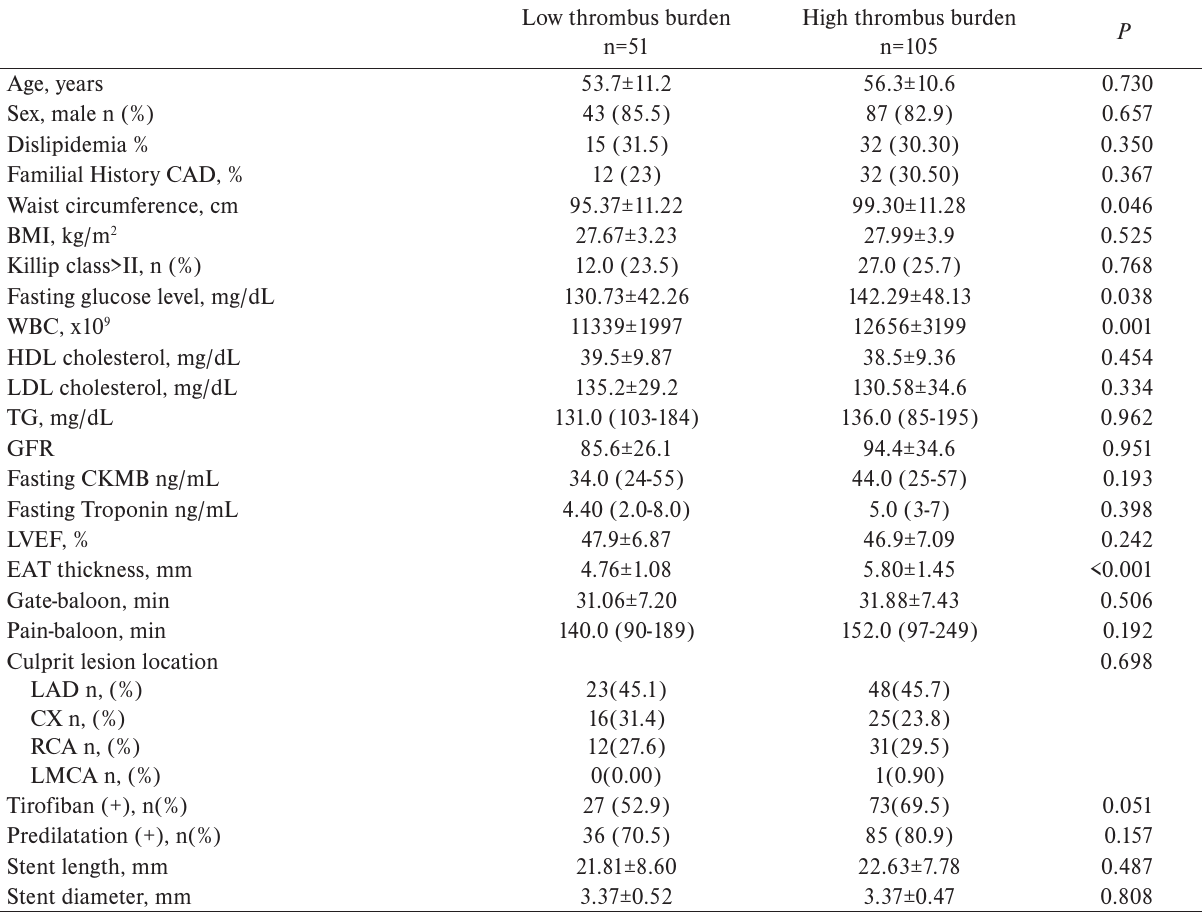
Table 1. Baseline clinical and angiographic charactersitics between patients with low vs high thrombus burden.